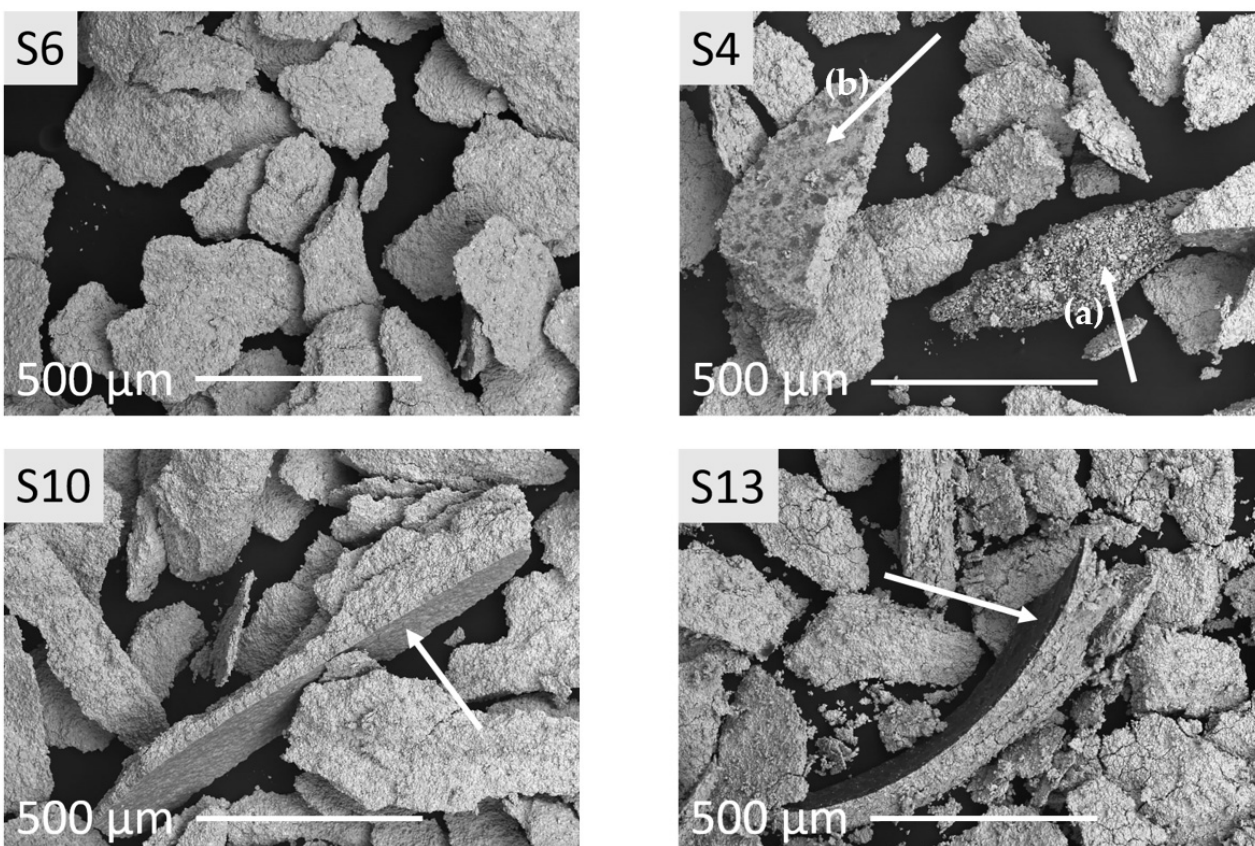
Figure A4. SEM pictures of HPMS powder samples after sieving; showing very good agreement with ICP results. ( S6 ) No residues found. ( S4 ) Arrows indicate fine agglomerates of Nd-Fe particles (a) and surface contaminations of SiO (b) resulting from the passivation. ( S10 ) Arrow indicates large coating flake. ( S13 ) Arrow indicates large coating flake.